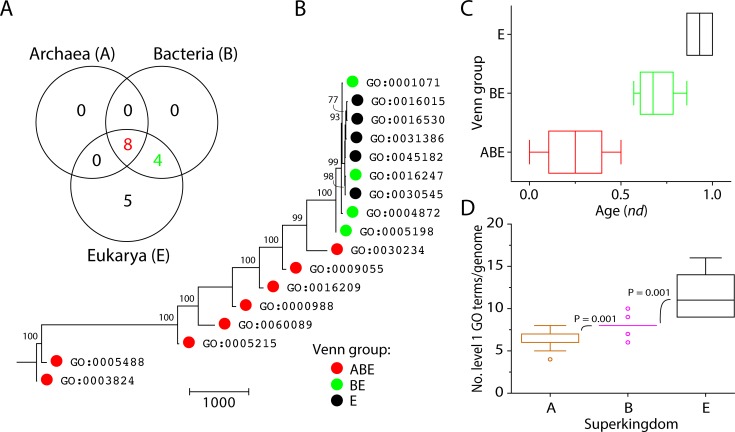
The distribution and evolution of level 1 GO terms in functionomes.(A) A Venn diagram illustrates the distribution patterns of level 1 molecular functions in the three superkingdoms, Archaea (A), Bacteria (B), and Eukarya (E). (B) The phylogenomic tree (tree length = 6820 steps) portraying the evolution of level 1 GO terms, with Venn distribution group-labeled leaves. Nonparametric bootstrap support (BS) values are shown above branches, which are supported by more than 50% of 1,000 replications. The tree was rooted by the Lundberg method. RI = retention index = 0.95, CI = consistency index = 0.85, Hi = homoplasy index = 0.15, and g1 = gamma distribution parameter = –0.72. (C) Boxplots shows the distribution of level 1 GO terms along the timeline in the three taxonomic groups. (D) Boxplots shows the number of level 1 GO terms per genome. Comparisons are significant at 0.001. A: Archaea, B: Bacteria, E: Eukarya.